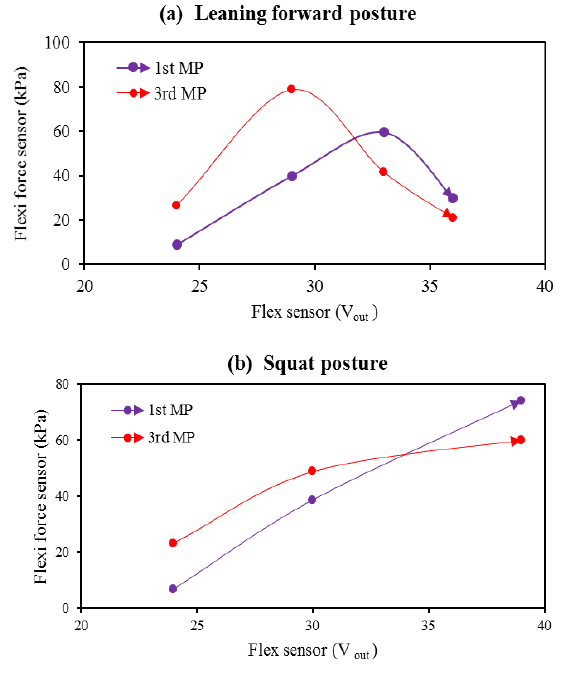
Figure 11. During ( a , b ) posture; the Flexi force senor’s response against the flex sensor.